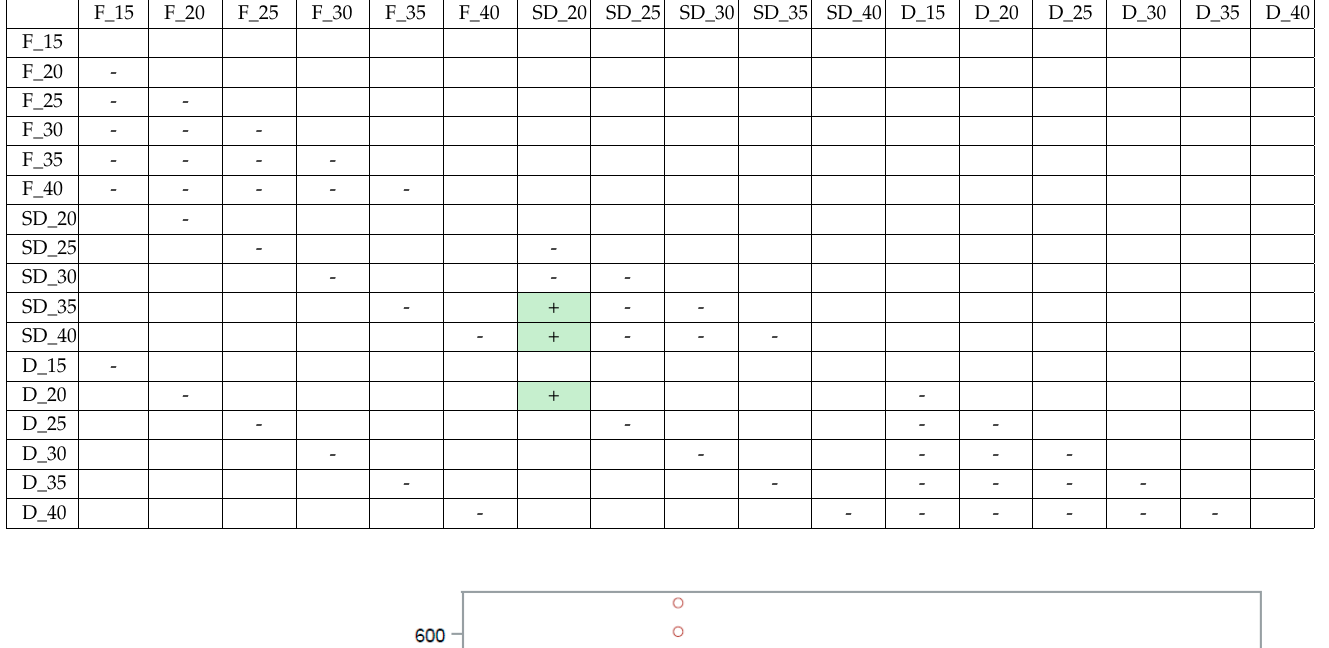
Table A5. WHC (mass based) significance − 5 kPa, plus (+) and green background indicates significant differences, minus (-) indicates statistically insignificant differences.